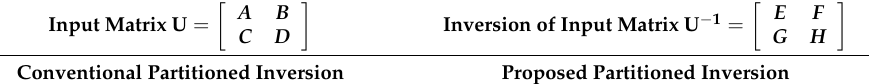
Table 2. Conventional partitioned inversion versus proposed partitioned inversion.